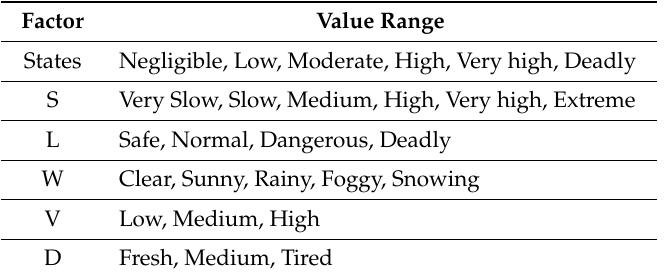
Table 2. Observation